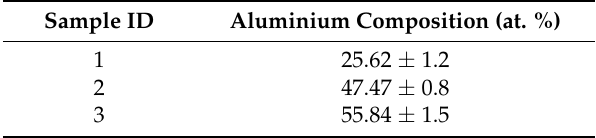
Table 1. Aluminium feed rate relating to final composition after heat